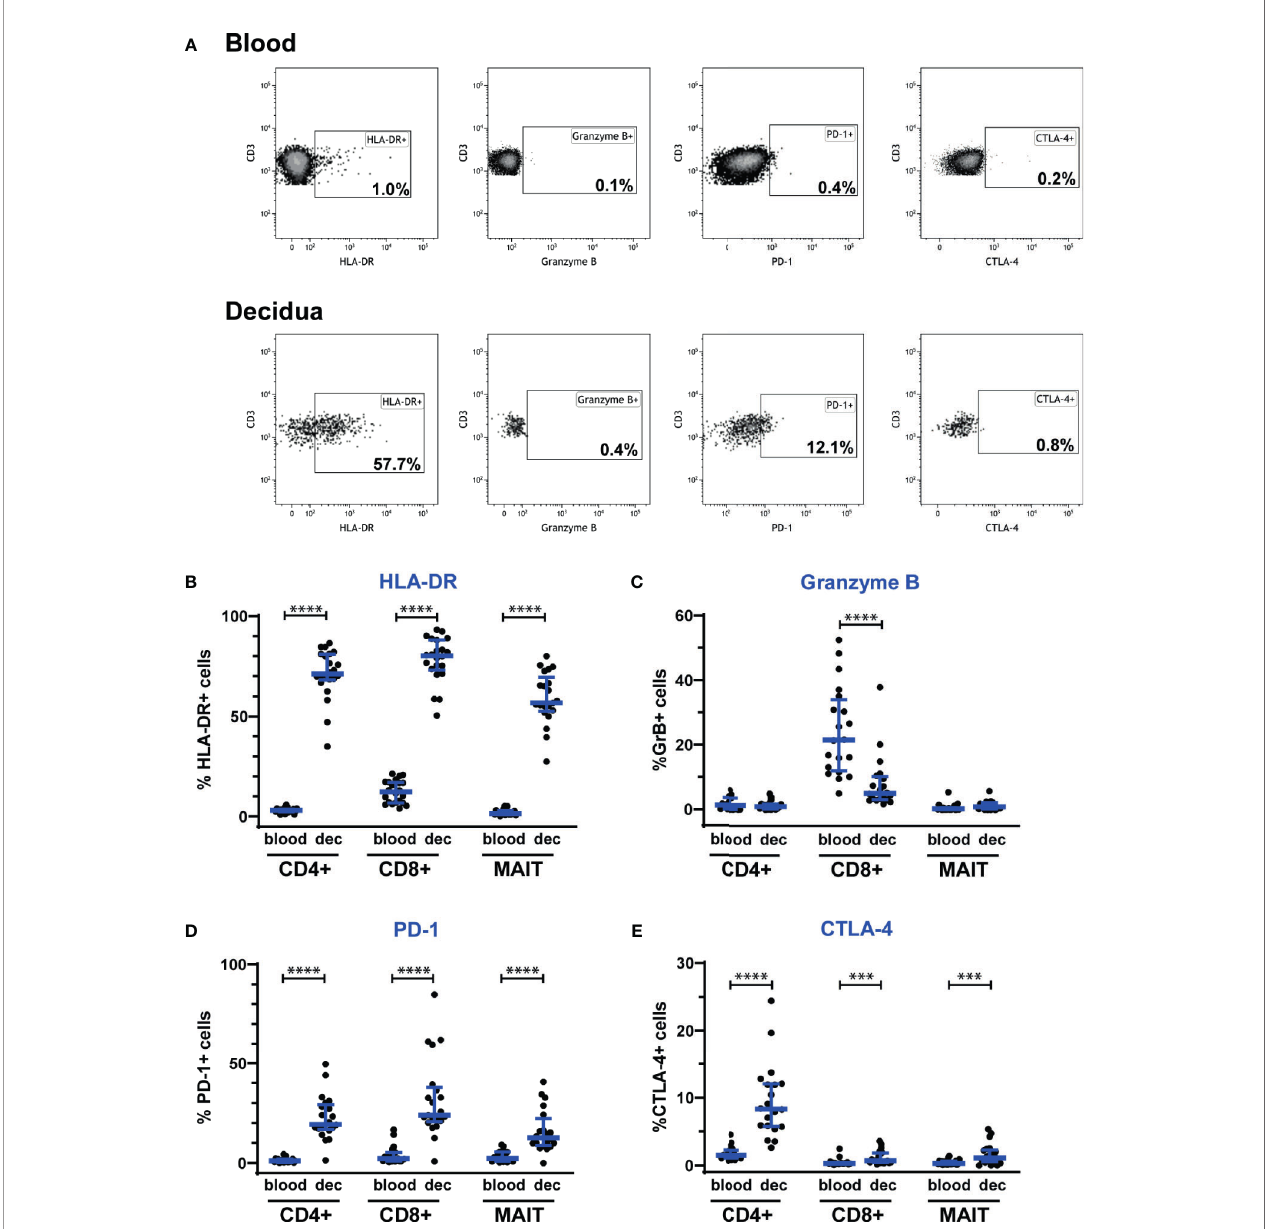
FIGURE 3 | Decidual MAIT cells express activation and immune checkpoint markers and exhibit a fundamentally different phenotype than circulating MAIT cells from the same women. PBMCs and decidual cells were isolated from blood and decidual tissue (dec), respectively, from the same donors, and analyzed by fl ow cytometry. (A) illustrates the gating strategy employed for the phenotypic markers HLA-DR, granzyme B, PD-1, and CTLA-4 on V a 7.2 + CD161 + MAIT cells for one representative blood and decidua sample. Positive gates for HLA-DR, granzyme B and PD-1 were set based on isotype controls, whereas the gate for CTLA-4 was set visually. Expression of (B) HLA-DR, (C) granzyme B, (D) PD-1 and (E) CTLA-4 by CD4 + T cells (CD4+), CD8 + T cells (CD8 + ) and MAIT cells (MAIT). Results for HLA-DR and PD-1 were based on cell surface staining, whereas granzyme B and CTLA-4 were stained intracellularly. From the CD4 + and CD8 + T cells, V a 7.2 + CD161 + cells were excluded, i.e. , the CD4 + and CD8 + T cell populations do not comprise any MAIT cells. Results for NK cells based on the same samples are shown in Supplementary Figure S4 . Bars show median and IQR from 20-22 donors. Statistical comparisons were performed with Wilcoxon signed-rank test. *** p < 0.001, **** p <